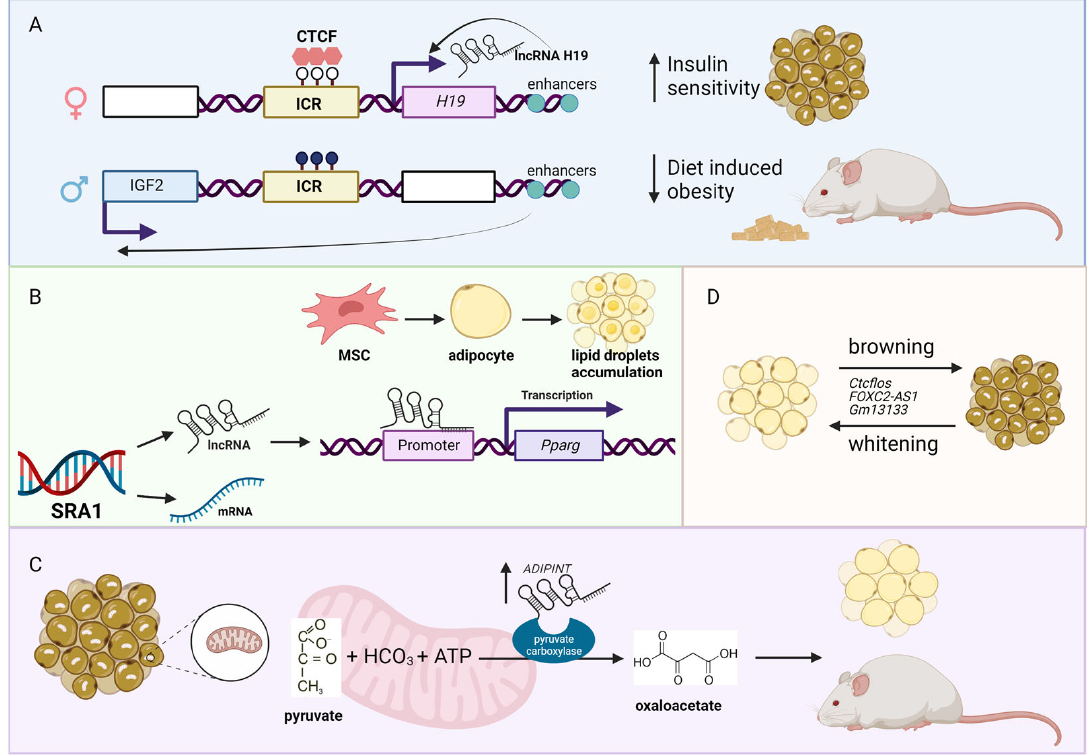
Figure 1. LncRNAs associated with obesity. ( A ) The H19 – IGF2 locus consists of a maternal unmethylated (white lollipops in the image above) imprinting control region (ICR; yellow box). ICR is bound by the insulator protein CCCTC-binding factor (CTCF), which prevents access of the IGF2 promoter (blue box represents the exon from the paternal chromosome) to downstream enhancers. The overexpression of the lncRNA H19 (pink box represents the exon from the maternal chromosome) in mice has a protective effect against diet-induced obesity and increased insulin sensitivity. In the image above, white boxes represent the repressed genes, while black lollipops represent the methylated CpG sites. ( B ) The SRA1 gene encodes for protein-coding mRNA and lncRNA Sra1 . The lncRNA Sra1 functions as a transcription co-activator of peroxisome proliferator-activated receptor gamma (Pparg), which is a regulator of adipocytes differentiation and lipid accumulation. ( C ) The lncRNA ADIPINT is upregulated in obesity. This lncRNA is responsible for adipocyte size, insulin resistance, and pyruvate carboxylase activity. ( D ) Several lncRNAs have been identified to be involved in the process of browning and whitening in the adipose tissue, which could serve as potential therapeutic targets. Figure created with BioRender.com (accessed on 10 January